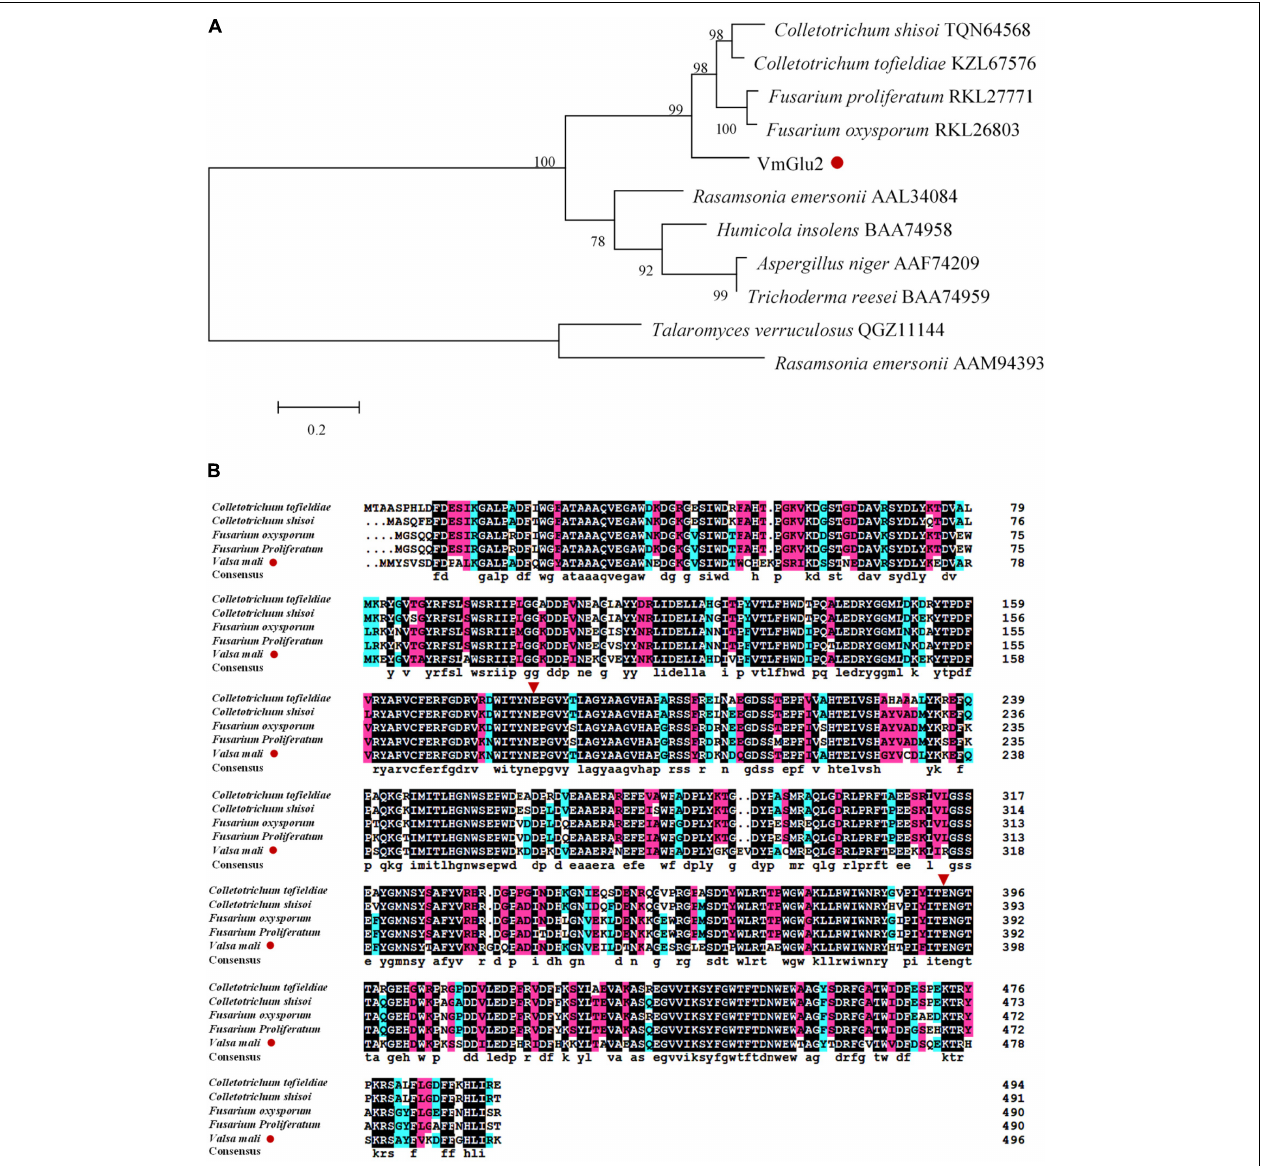
FIGURE 1 | Bioinformatics analysis of VmGlu2 (Accession number: KX013493). (A) Phylogenetic analysis of VmGlu2 with the well-characterized β -glucosidase from GH1 family. The phylogram was generated by the Maximum likelihood method implemented in the MEGA7. Numbers beside each node indicate bootstrap values as a percentage of 1,000 replicates. Species names are followed by the accession numbers of β -glucosidase protein. (B) Multiple alignments of the amino acid sequences of VmGlu2 with known β -glucosidases from other fungi are given. Red inverted triangles indicate the catalytic residues among GH1